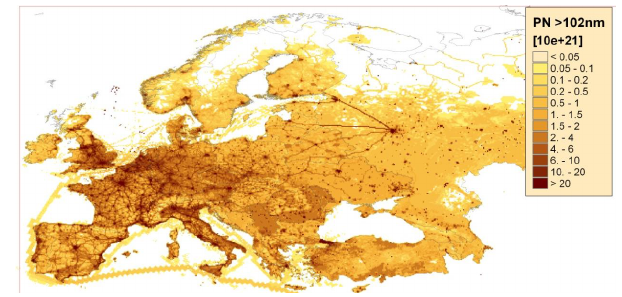
Fig. 2. Emission of particle numbers from 100–300nm in Europe for the year 2005 (Denier van der Gon et al.,